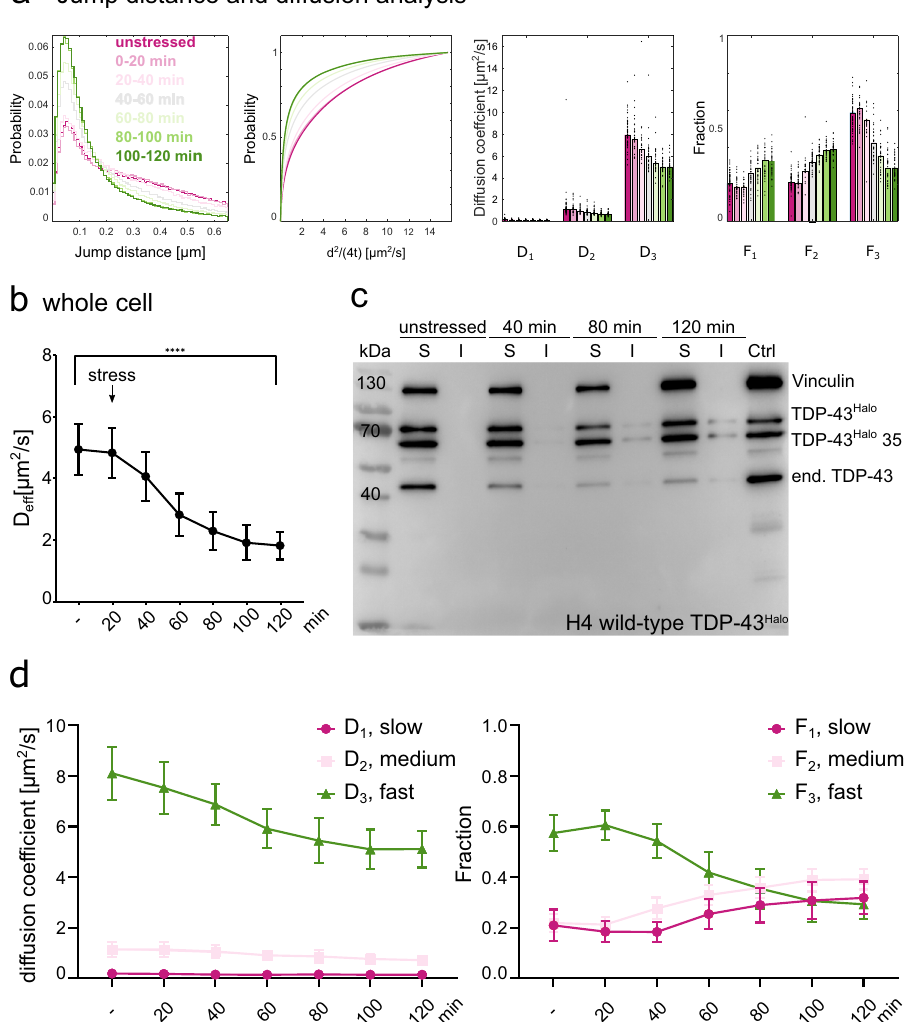
Fig. 3 | Sodium arsenite stress leads to a reduction of TDP-43 Halo mobility observedinsingle-moleculetracking.a Jumpdistanceanalysisand3-exponential fi ttingresultsgivingthreedifferentdiffusioncoef fi cientsandfractions,slow(D 1 /F 1 ), medium (D 2 /F 2 ) and fast (D 3 /F 3 ), in a stress-time-course experiment of TDP-43 Halo cells. Stress duration increased from unstressed (magenta) to 120min (green) of 0.5mM sodium arsenite stress. Data are presented as mean values overlayed with the corresponding data points displaying the movie wise spread of data. b Stress time course of the effective diffusion coef fi cient D eff for the TDP-43 Halo construct (whole cell, mean + STD, two-tailed Welch ’ s t -test, p -value=<0.0001). Source data are provided as a Source Data fi le. c . Solubility assay of the TDP-43 construct. Table1,theexperimentscellswereexaminedinindependentexperiments.).Source data are provided as a Source Data fi